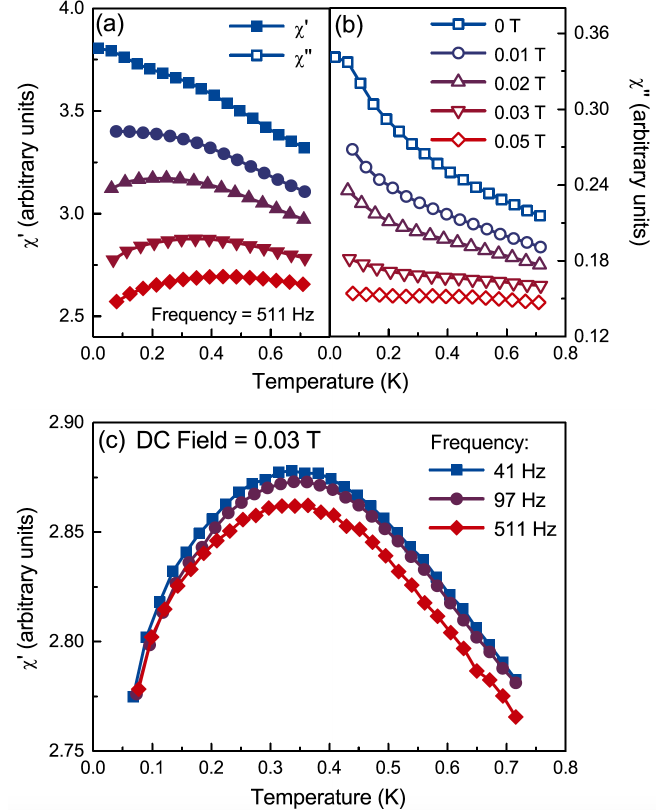
Figure 9. (color online) The ( a ) real, χ (cid:48) , and ( b ) imaginary, χ ”, components of the ac susceptibility of Tb 2 Ge 2 O 7 . ( c ) A dc field of 0.03 T induces a frequency independent peak that shifts to higher temperatures with increasing field. From Ref.